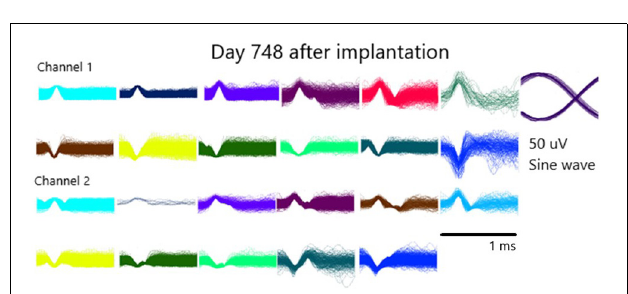
with hematoxylin. Positive controls and negative controls were included in each immunohistochemical staining